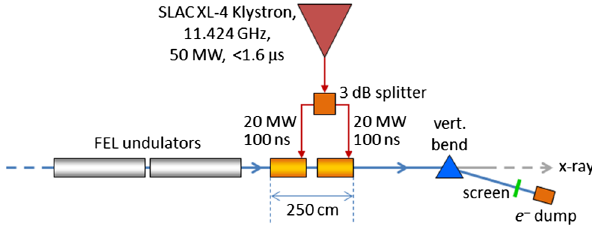
FIG. 1. Schematic layout of LCLS deflector rf system.